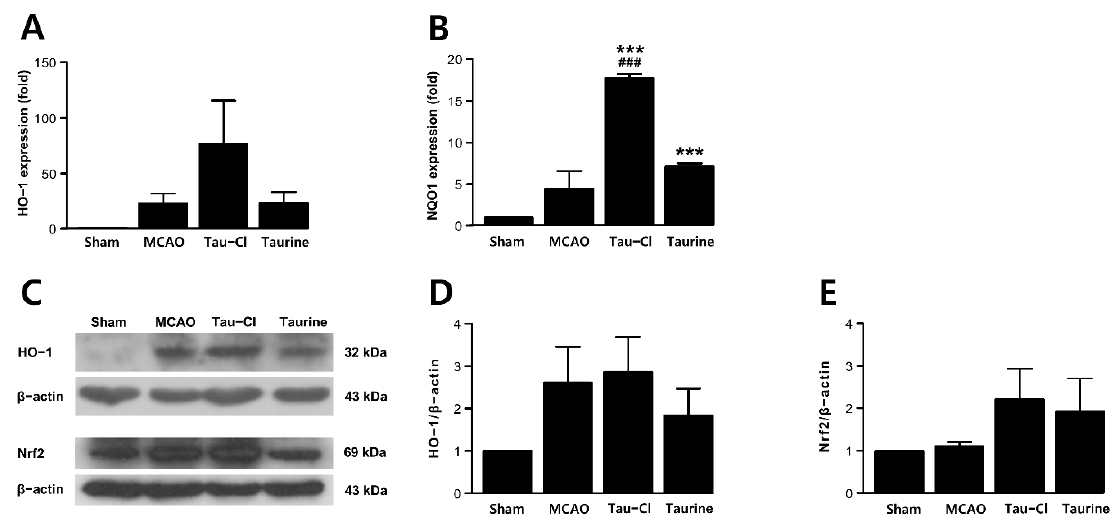
Figure 5. Tau-Cl increased the expression of antioxidant enzymes in the post-MCAO brains. Brain samples for qRT-PCR and immunoblot analysis were prepared from cerebral cortex indicated in Figure 3A at 24 h post-MCAO. ( A , B ) The expression levels of mRNA of HO-1 ( A ) and NQO1 ( B ) were determined by qRT-PCR (n = 3). ( C – E ) The protein levels of HO-1 and Nrf2 were determined by immunoblotting ( C ), and blots quantified by using the Image J software are presented as arbitrary density units ( D , E ) (n = 3). Results are presented as mean ± SEM, *** p < 0.001 vs. sham control, and ### p < 0.001 vs. PBS-treated MCAO controls by one-way ANOVA with Student – Newman – Keuls test.